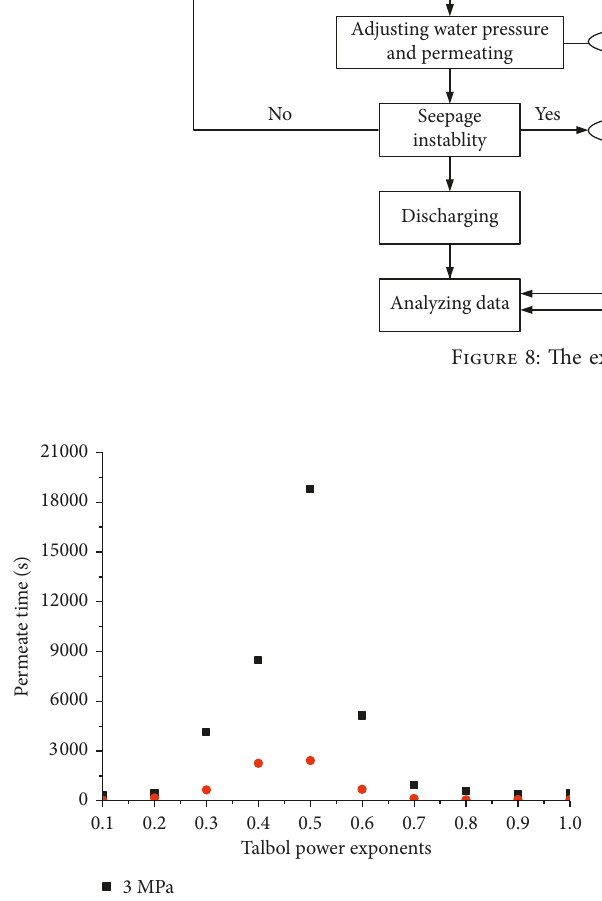
Figure 10: The time-varying curves of water pressure and water